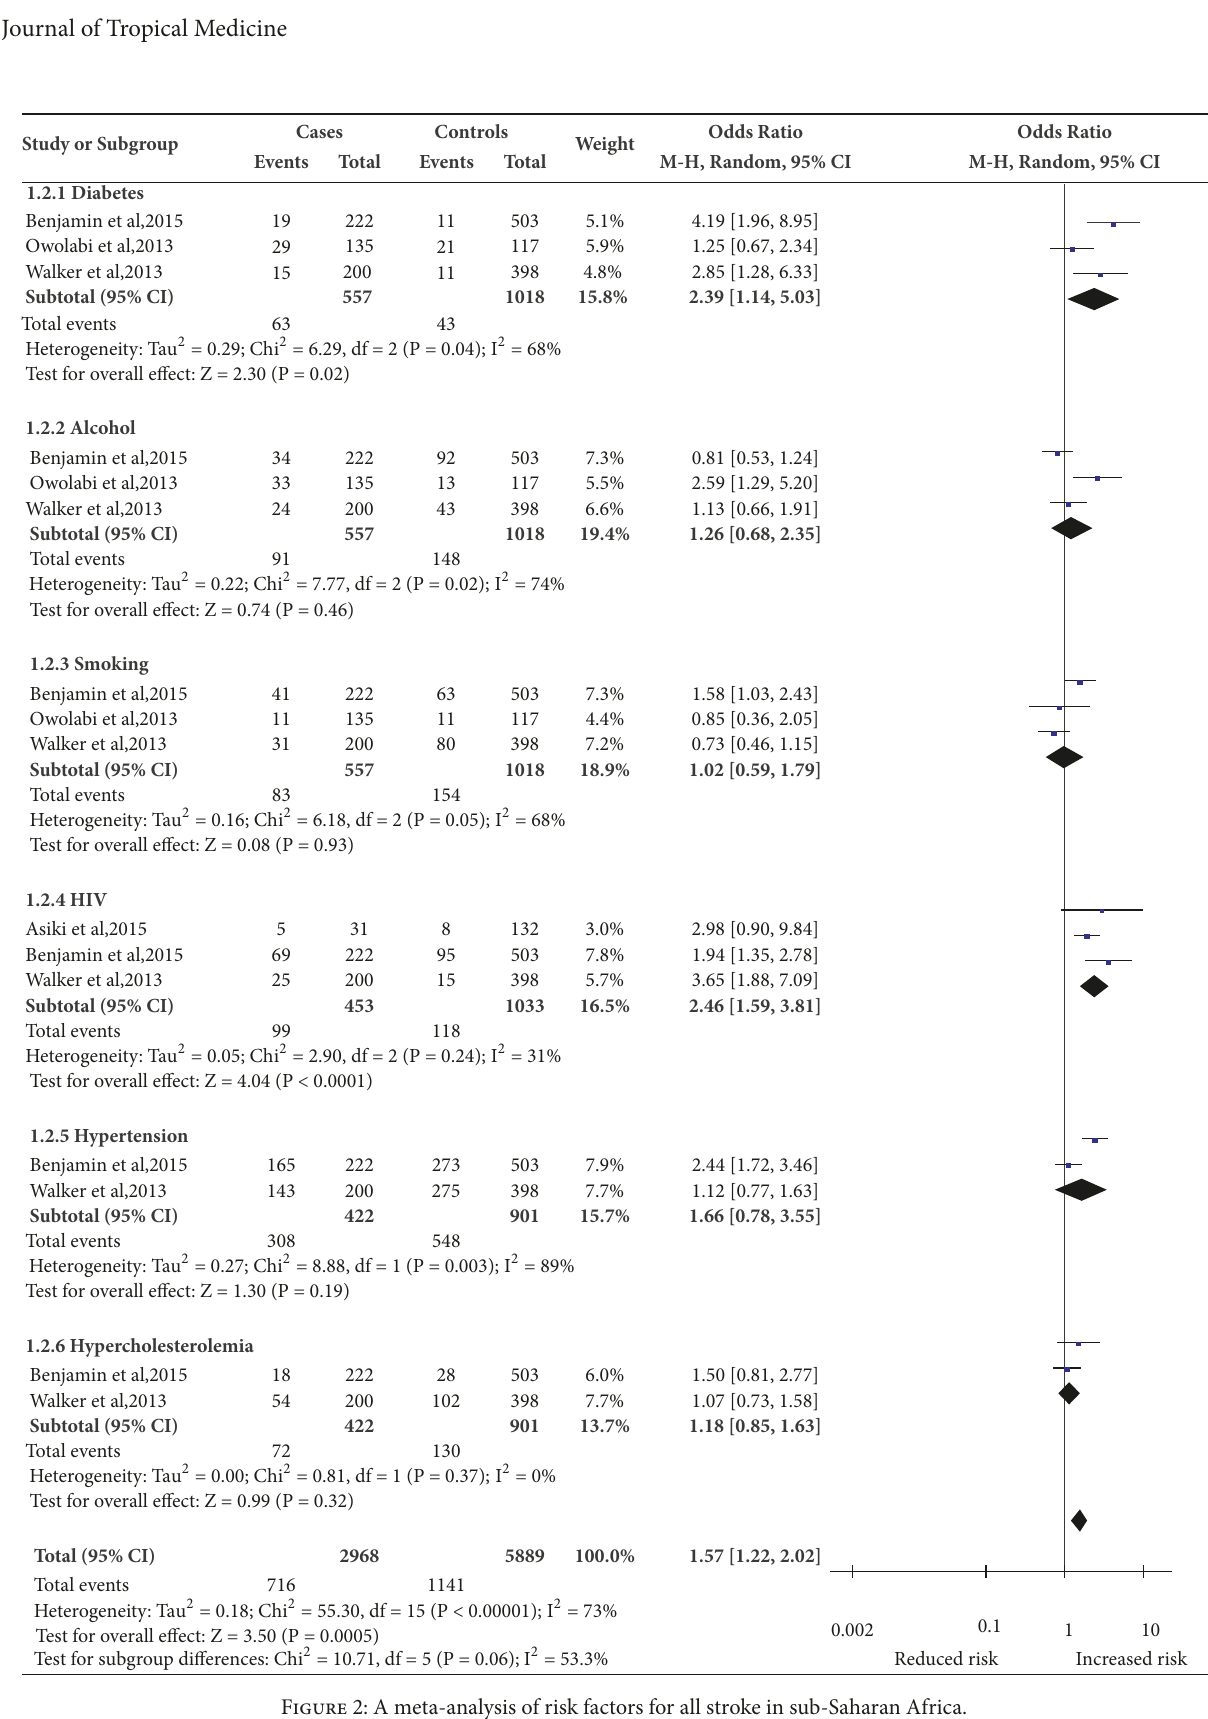
Figure 2: A meta-analysis of risk factors for all stroke in sub-Saharan